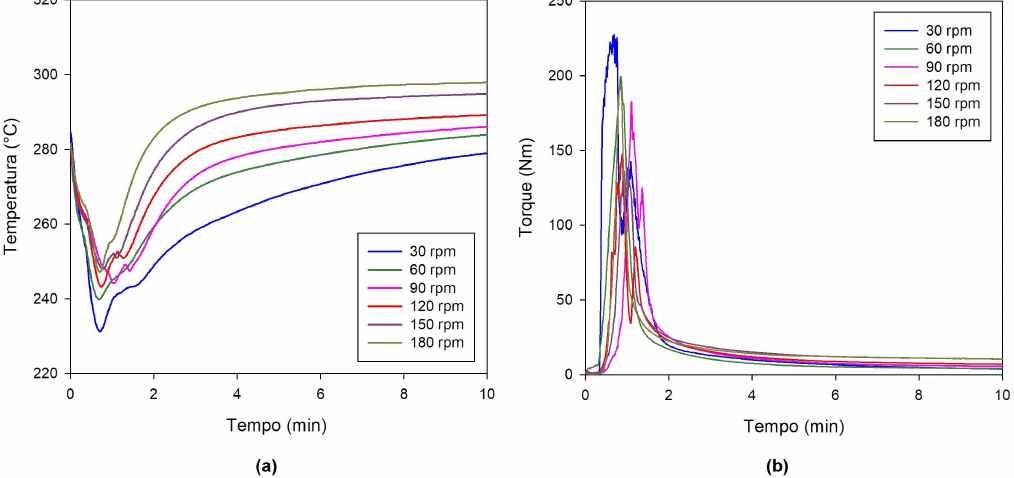
Figure 2. Temperature (a) and torque (b) as a function of time for testes performed at a given chamber temperature ( T various rotor